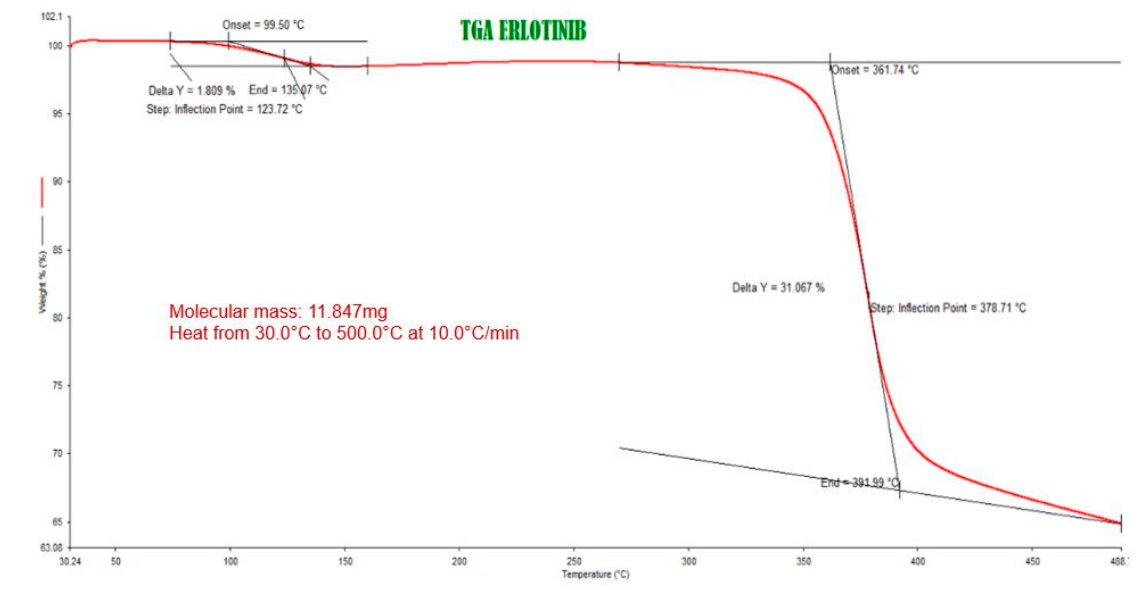
Figure 2. Erlotinib thermogram. Table 4. Data from thermograms.